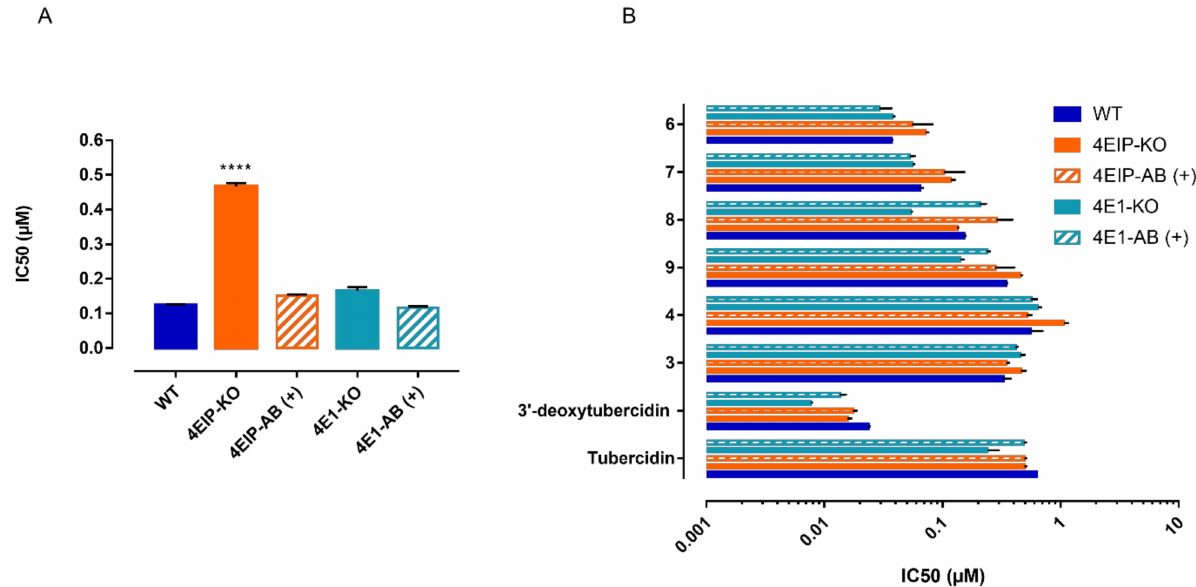
Figure 5. Susceptibility of 4EIP and 4E1 knockout cell lines to 5 ( A ) and compounds 1 – 4 , and 6 – 9 ( B ). Results are expressed as the mean IC 50 ( µ M), and error bars represent SEM and are based on at least two independent experiments ( n = 2), each with two biological replicates. + = tetracycline-induced clones. **** p < 0.0001, Kruskal–Wallis test with Dunn’s multiple comparison test.